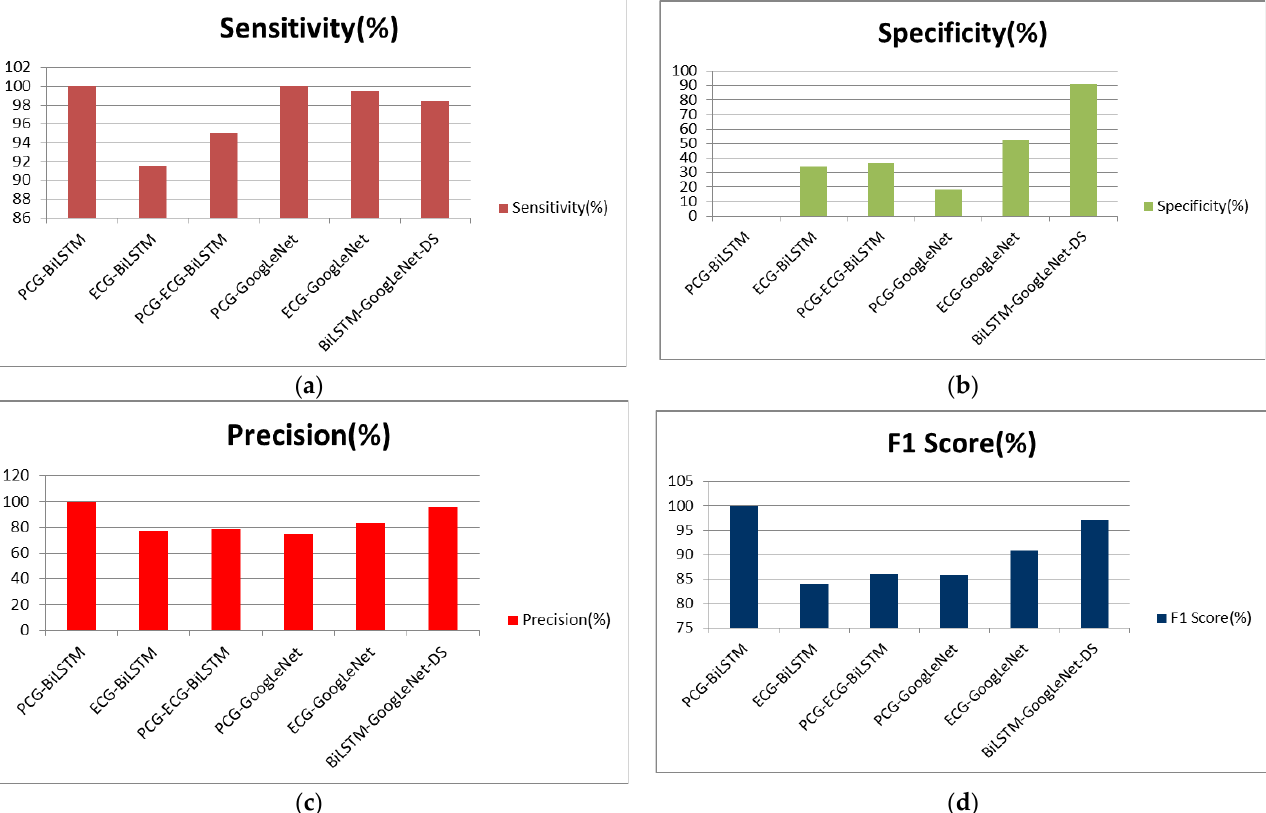
Figure 14. The comparison of sensitivity, specificity, precision, F1 score: ( a ) the comparison of sensitivity; ( b ) the comparison of specificity; ( c ) the comparison of precision; ( d ) the comparison of F1